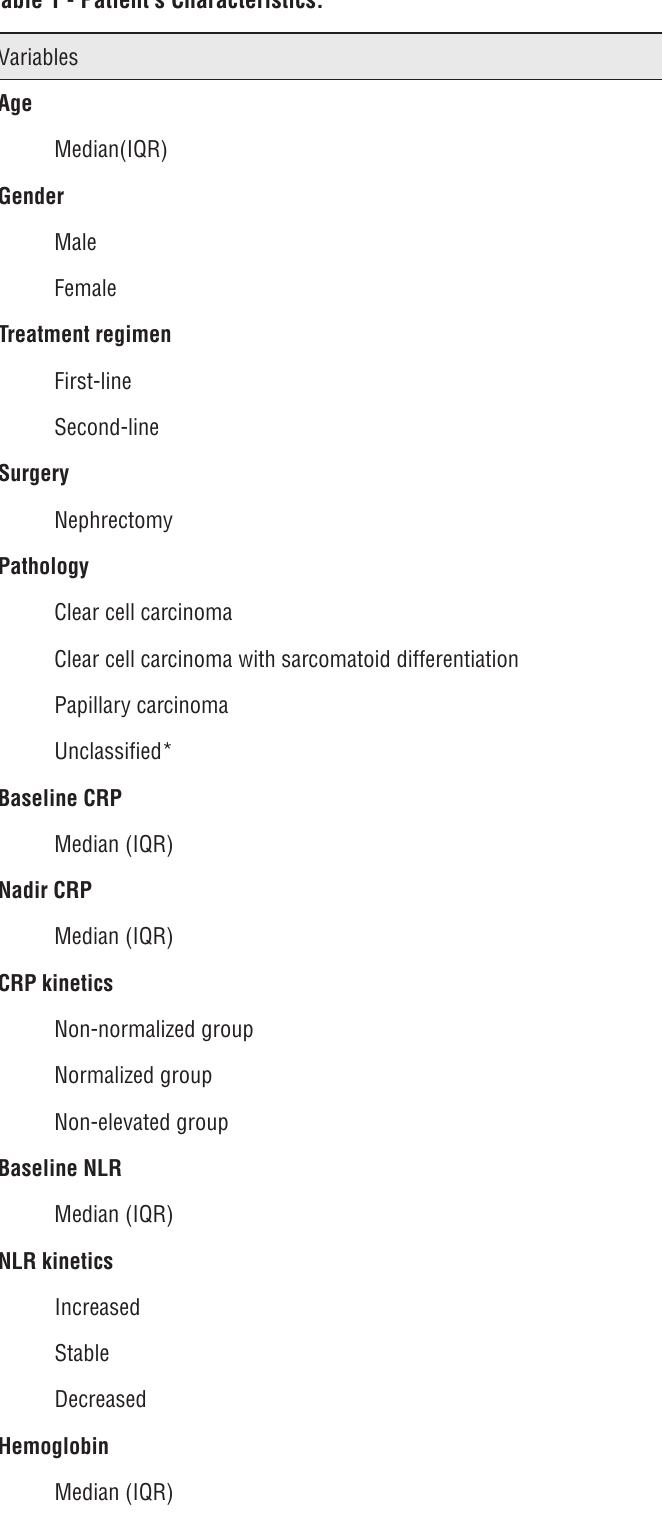
Table 1 - Patient’s